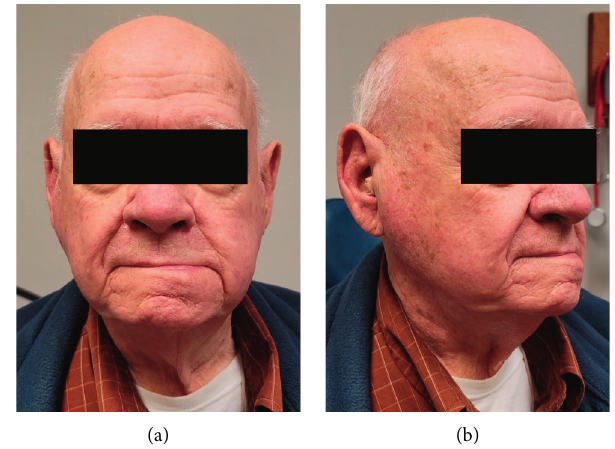
Figure 3: Five-month postoperative follow-up.